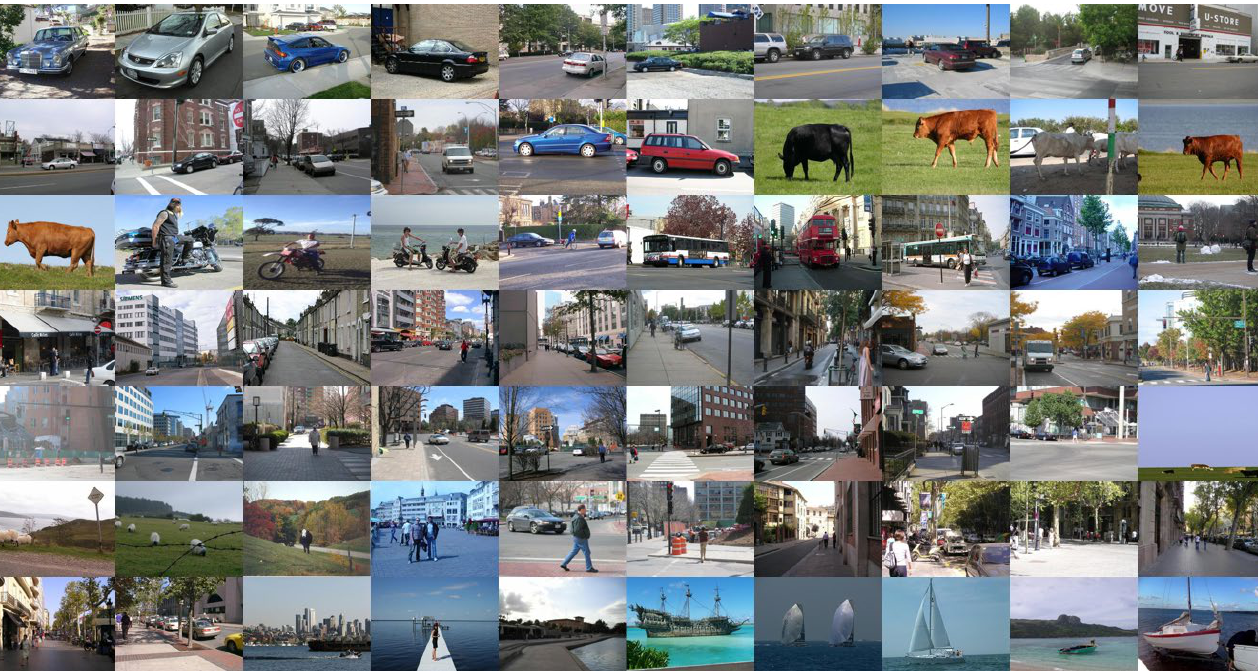
Fig. 11. A validation set of 52 images in the dataset with just 4 scene categories. The dataset is of 534 images [20]. This SIS-generated task has only 70 and 48 training samples for categories “house-about” and “road”, respectively. The other two categories, consisting of 235 and 181 images, have many similar entries.